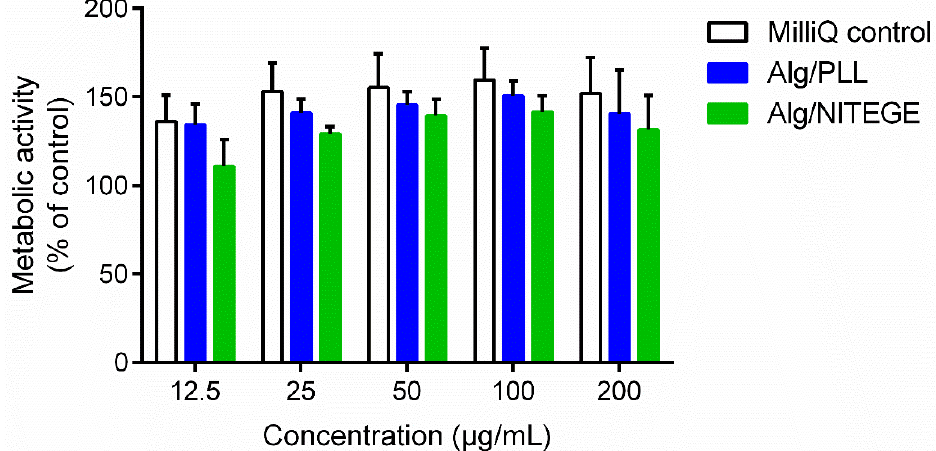
Figure 7. Metabolic activity of human gingival fibroblast (HGFIB) in response to Alg/PLL and Alg/NITEGE nanoparticle suspensions after 24 h. Alg/PLL and Alg/NITEGE nanoparticles and MilliQ water as control were diluted in DMEM with 5% FCS. Untreated cells were set to 100% metabolic activity. Mean and standard deviation of three independent experiments are shown.